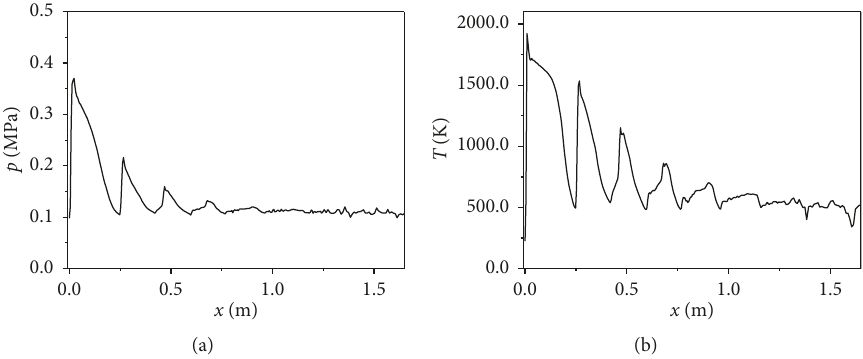
Figure 5: Flow parameters distribution along the inner surface. (a) Pressure. (b) Temperature.